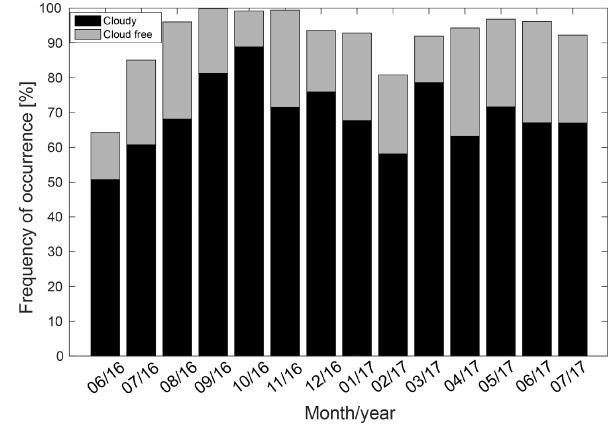
Figure 4. Cloudnet data availability for Ny-Ålesund for June 2016 to July 2017. Grey bars correspond to clear-sky profiles, black bars to cloudy profiles, and white space means no Cloudnet data avail-